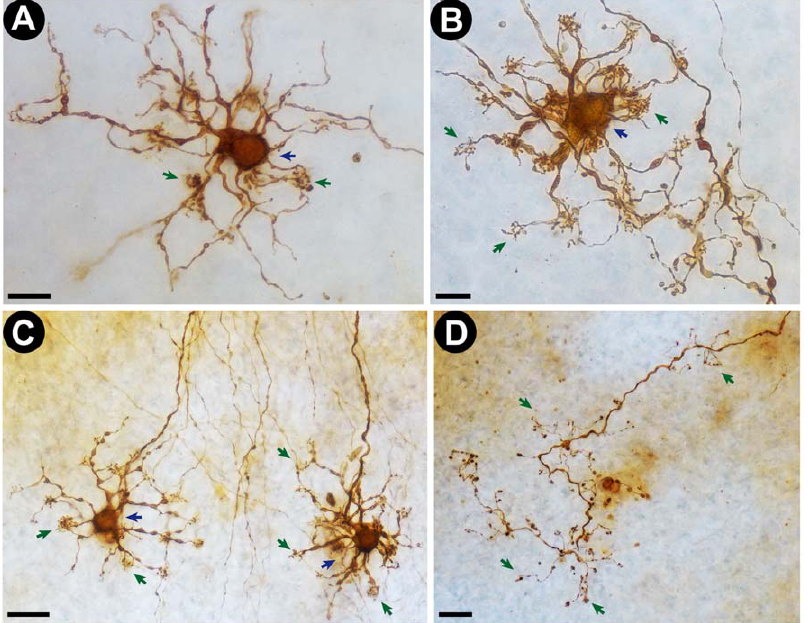
Figure 4. Representative photomicrographs of human retinal neurons and axons stained by the new photooxidation method. Cells were processed and observed in intact post-mortem human retinas. A and B: High magnification (100 6 objective lens) photomicrographs of DAB- stained putative horizontal retinal neurons. Note the clear delineation of the cell body (blue arrows) and dendritic tufts (green arrows). Scale bars correspond to 10 m m. C: Low magnification (40 6 objective lens) photomicrograph of two DAB-stained retinal cells (putatively horizontal cells). Scale bar corresponds to 20 m m. D: Low magnification (40 6 objective lens) photomicrograph of a DAB stained axon terminal in a sample of human retina. Note that even fine structures, such as axonal knobs (arrows), are clearly stained. Scale bar corresponds to 20 m m.